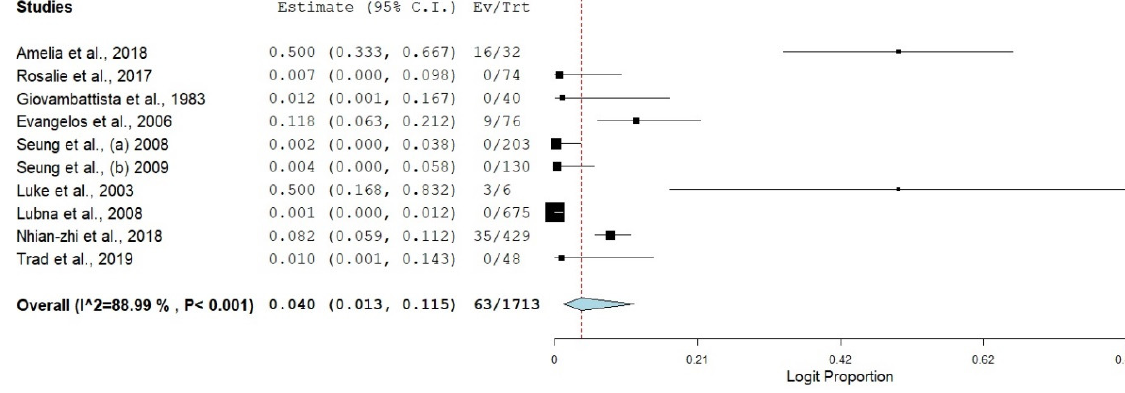
Figure 5. Forest plot showing SBP in HCV cirrhosis [17–26]. Figure 5. forest plot showing SBP in HCV cirrhosis [17–26].